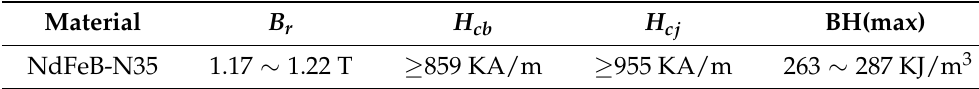
Table 1. Parameters of the NdFeB-N35 permanent